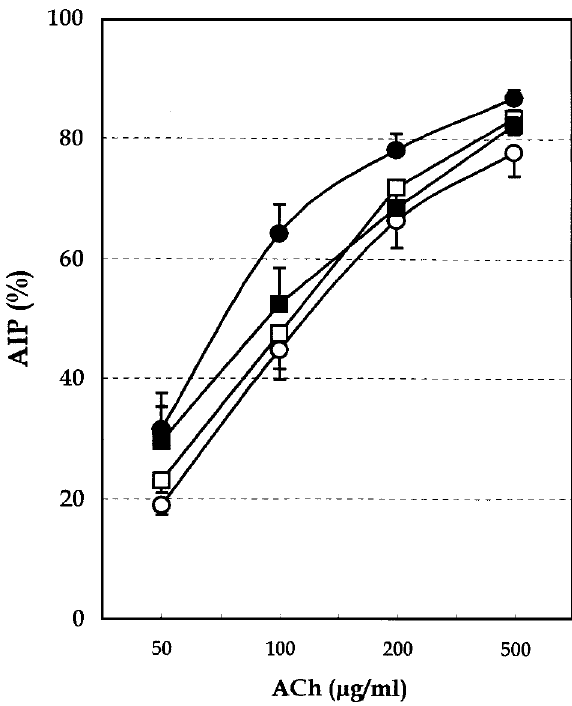
FIG. 1. Influence of Ro 20± 1724 (30mg/kg) on cumulative dose± response curve for acetylcholine (50, 100, 200 and 500 m g/ml) in anaesthetized guinea-pigs, 24h after ovalbu- min challenge (OA). Sensitized guinea-pigs were treated orally with Ro 20± 1724 (30mg/kg), 24 and 3h before the antigen challenge (OA) or saline exposure (SAL). Symbols represent control with ( h ) or without ( s ) Ro 20± 1724 and after OA challenge with ( j ) or without ( d ) Ro 20± 1724 ( n =6± 20). Significant difference between OA and Ro 20± 1724+OA is P <0.05. No significant difference is noted between SAL+Ro 20± 1724 and OA+Ro 20± 1724.